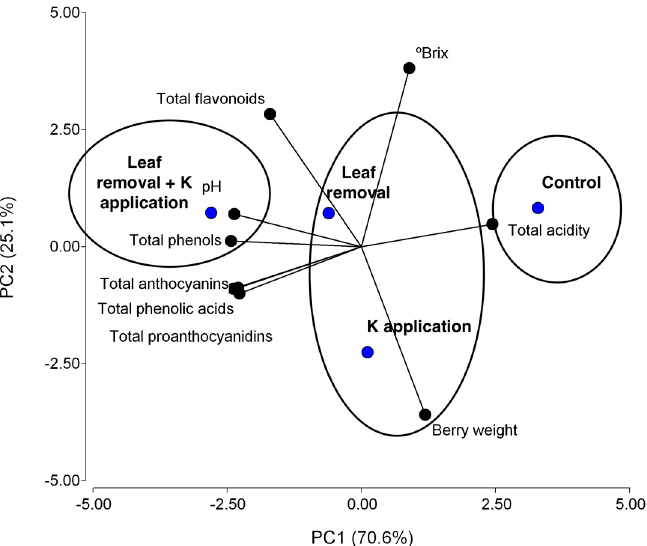
Figure 1. Principal component analysis (PCA) performed with berry parameters of Beibinghong vines subjected to different treatments: (i) leaf removal at véraison, (ii) potassium (K + ) foliar application, and (iii) leaf removal plus K + foliar application, as well as control. °Brix: total soluble solids. Total acidity: titratable acidity.